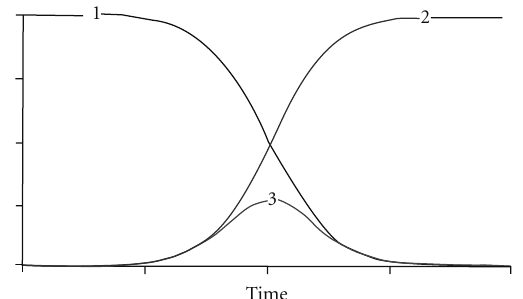
Figure 4: Theoretical model of the “butterfly” diagram: (1) negative growth curve, (2) positive growth curve, and (3) bell-shaped curve [11].